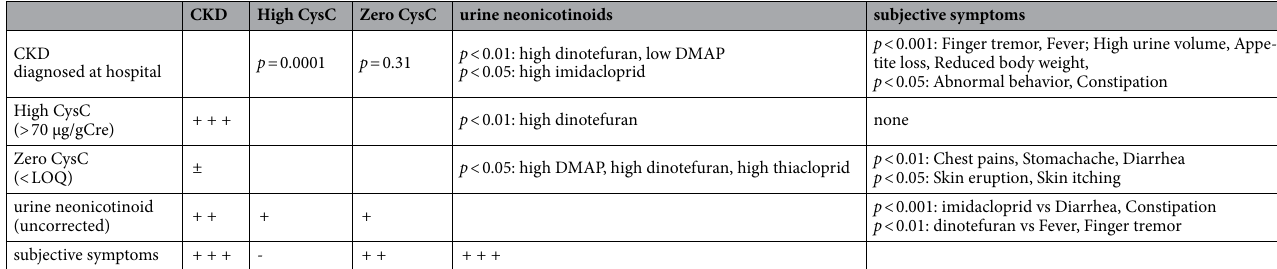
Table 10. Relationship between CKD diagnosis, high urine Cystatin-C, very low urine Cystatin-C, urine neonicotinoids/DMAP and subjective symptoms related to neonicotinoids exposure. + + + : p < 0.001, + + : p < 0.01, + : p < 0.05, ± : p <